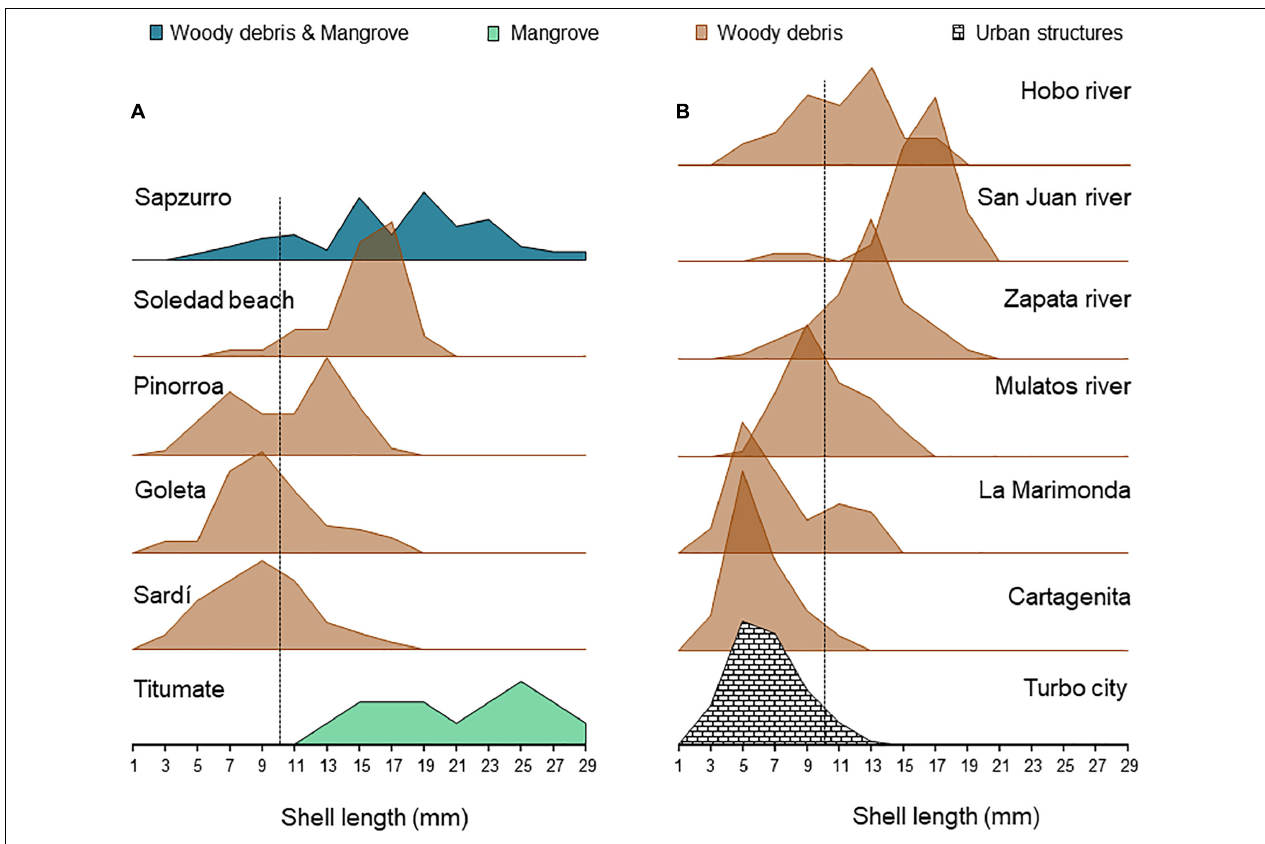
FIGURE 3 | Joy-plot of the north-south changes in length-frequency distributions of Littoraria angulifera populations across the western (A) and eastern (B) flanks of the Urabá Gulf from data taken in 2009, 2019, and 2020. Y -axis represents the percentage of each shell length with respect to total abundance in each place; dotted lines represent the approximate mean size at sexual maturity of L. angulifera in Panamá (Gutierrez, 1988) and Brazil (Costa et al., 2013). TABLE 1 | Mann-Whitney U tests assessing differences in the number of Littoraria angulifera between exposed and protected positions in different microhabitats. Microhabitat Rank sum (Exposed) Rank sum (Protected) U P -value Valid N (Exp) Valid N (Prot) Woody debris 299 . 5 690 . 5 46 . 5 < 0 . 001 22 22 24 . 0 54 . 0 3 . 0 0 . 020 6 6 21 . 0 57 . 0 0 . 0 0 . 005 6